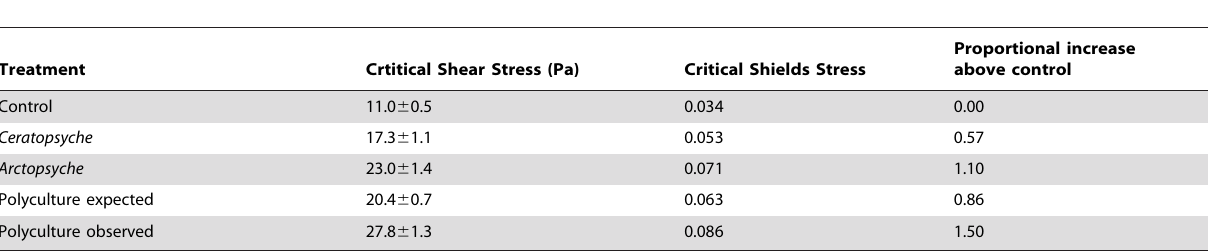
Table 1. The threshold of motion for each caddisfly treatment in the experiment.